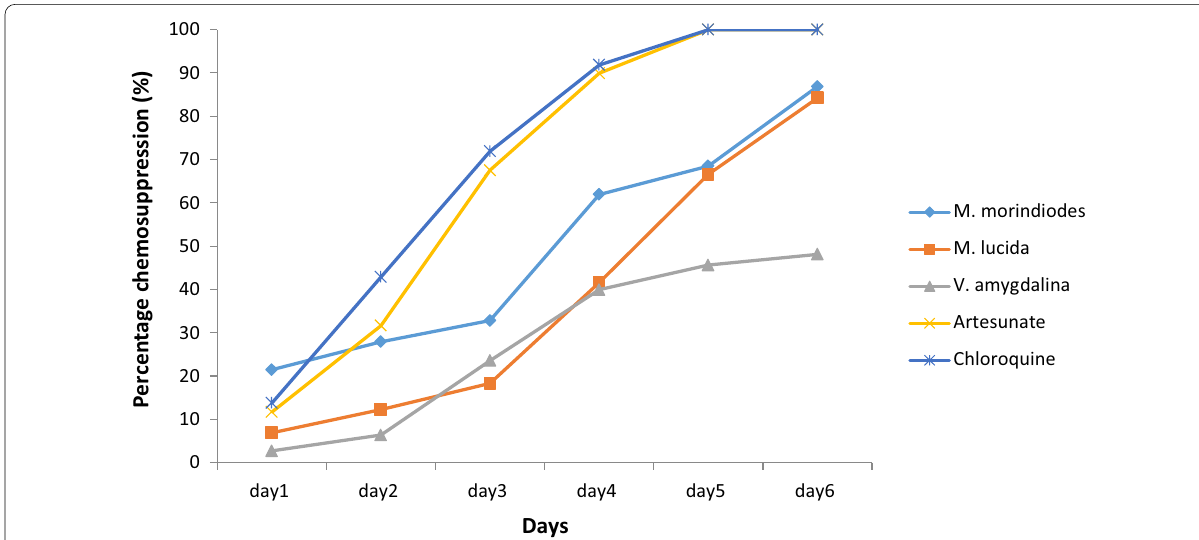
Fig. 1 Percentage chemosuppression of parasitaemia of infected mice treated with single